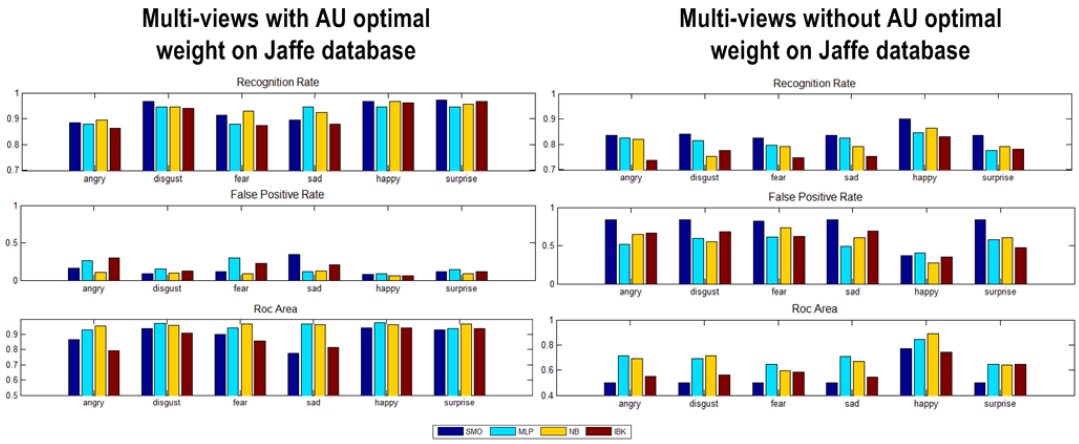
Figure 11. The results of the multi-layer AU fusion strategy on the JAFFE dataset.